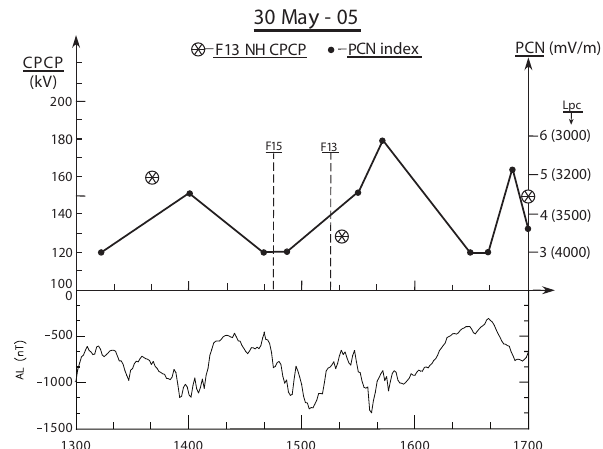
Fig. 10. The top panel shows CPCP estimates during the interval 13:00–17:00UT on 30 May 2005 as derived from DMSP F13 cross- track ion drifts (circled crosses at 13:37, 15:18, and 16:59UT) and the trend of the PCN-index (dots) taken from Fig. 3. The AL-index is shown in the bottom panel. Crossings of the dusk-side polar cap boundary by satellites F15 at 14:44UT (71 ◦ MLAT) and F13 at 15:14UT (74 ◦ MLAT) are indicated.